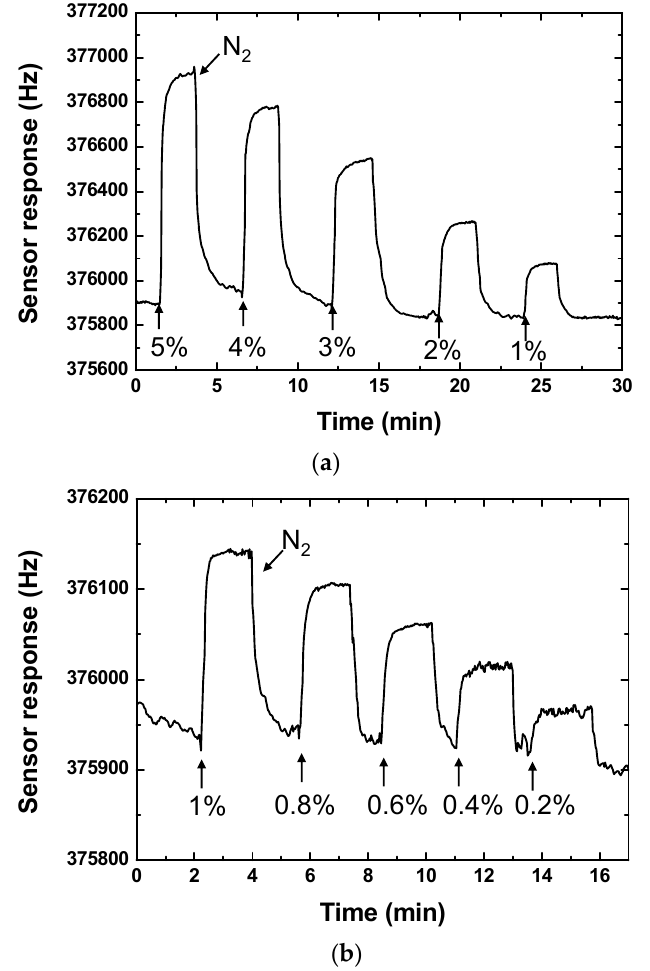
Figure 9. Responses of CrypA based SAW sensor to ( a ) High CH 4 concentrations and ( b ) Low CH 4 concentration at room temperature.